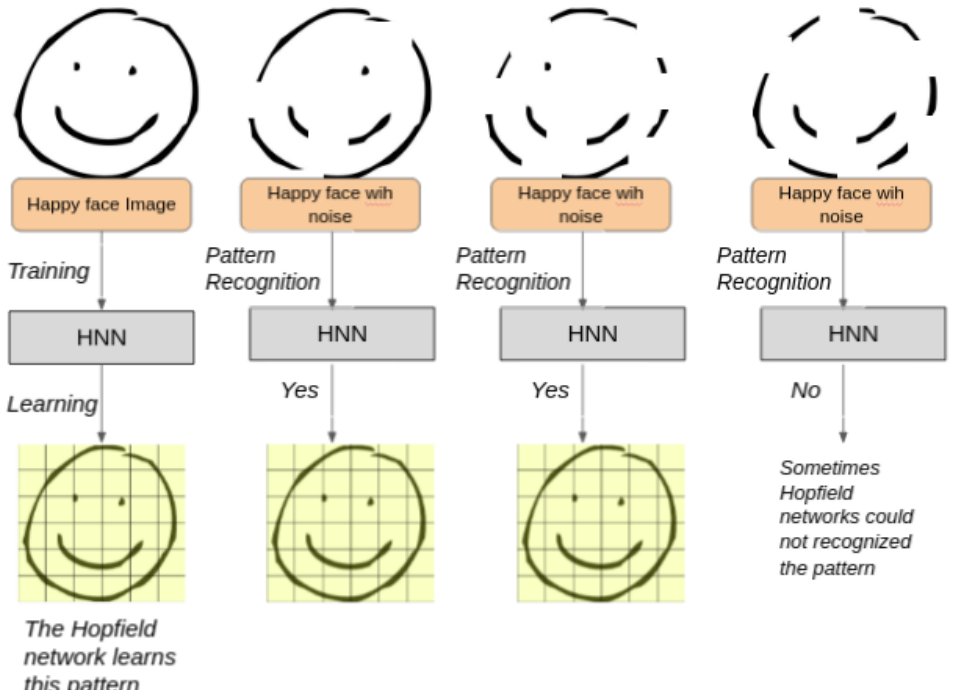
Figure 3. HNN applied to happy-face recognition: training and pattern recognition phases (hypo- thetical